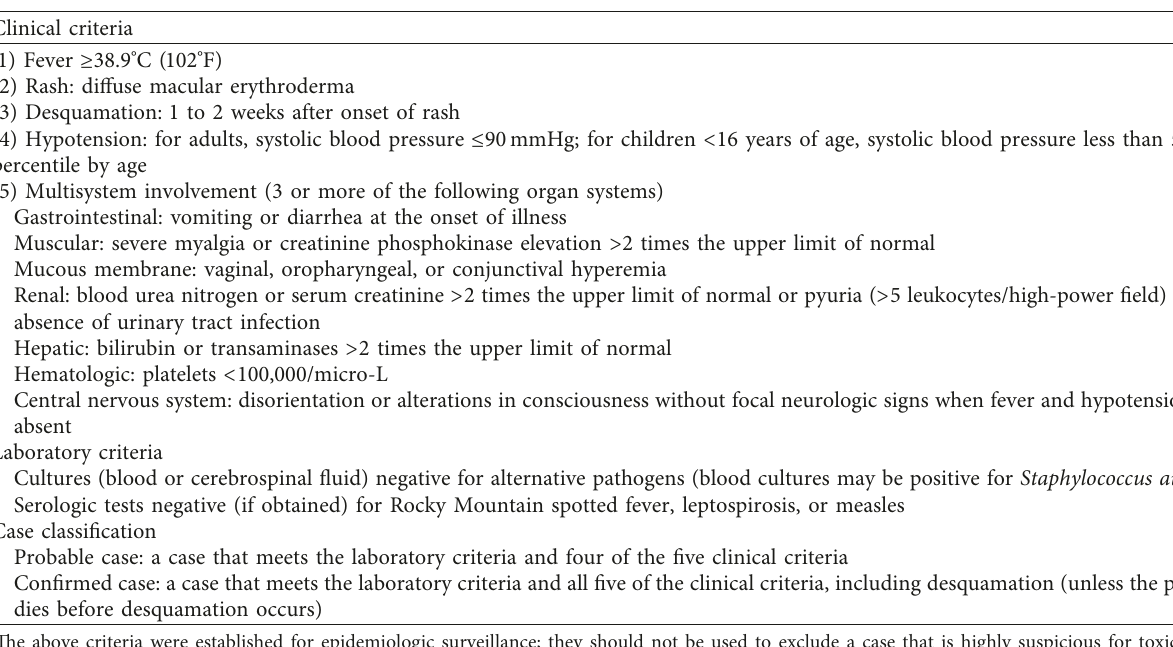
Table 1: Clinical criteria for diagnosis of staphylococcal toxic shock syndrome [7]. Clinical